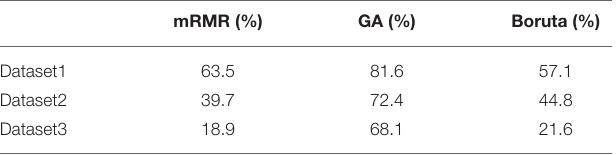
TABLE 3 | Percentage decrease in input features using different feature selection